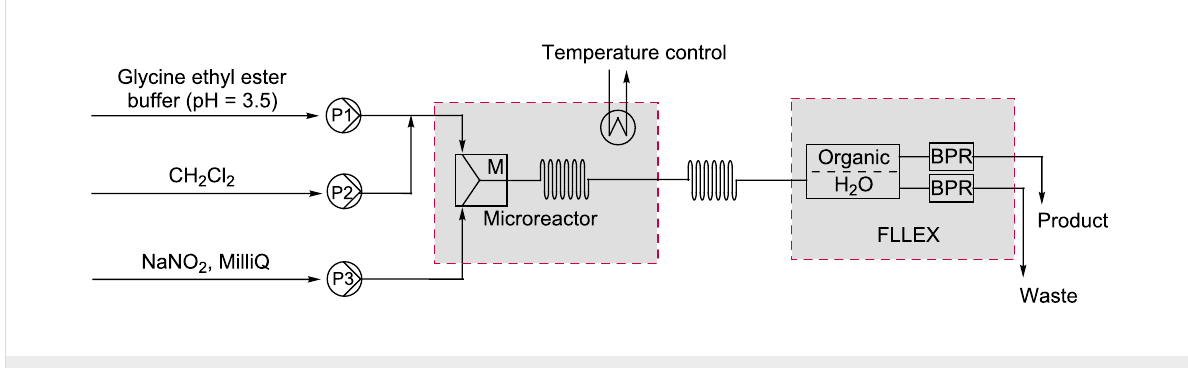
Figure 4: Phase separation using a Flow-Liquid–Liquid-Extraction module (FLLEX) directly coupled to the microreactor.